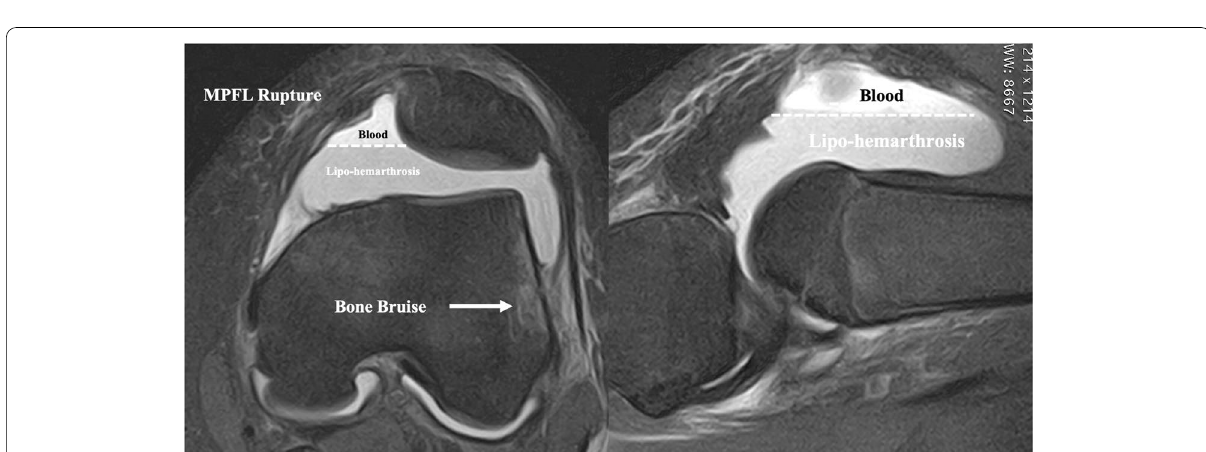
Fig. 6 First time patellar dislocation with Lipohemarthrosis, MPFL rupture and Bone bruise. Remember to search for osteochondral